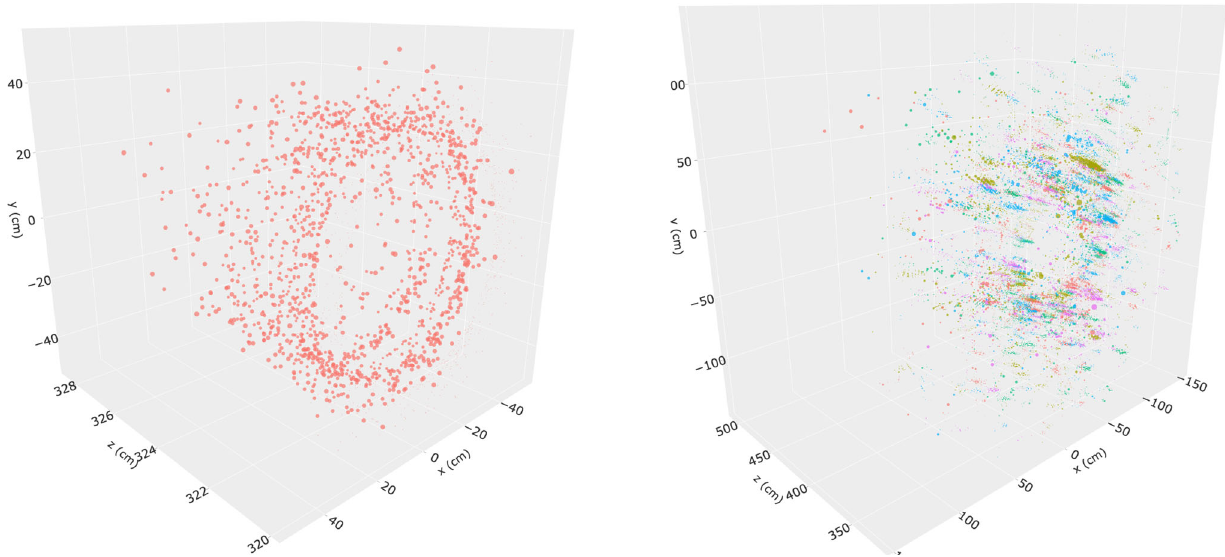
sizes. Different colors refer to different incoming primary particles. Marker sizes are proportional to log ( e h + 1 ) and are max normalized independently in both figures (the same method is used for choosing marker size for all the event displays in this article)